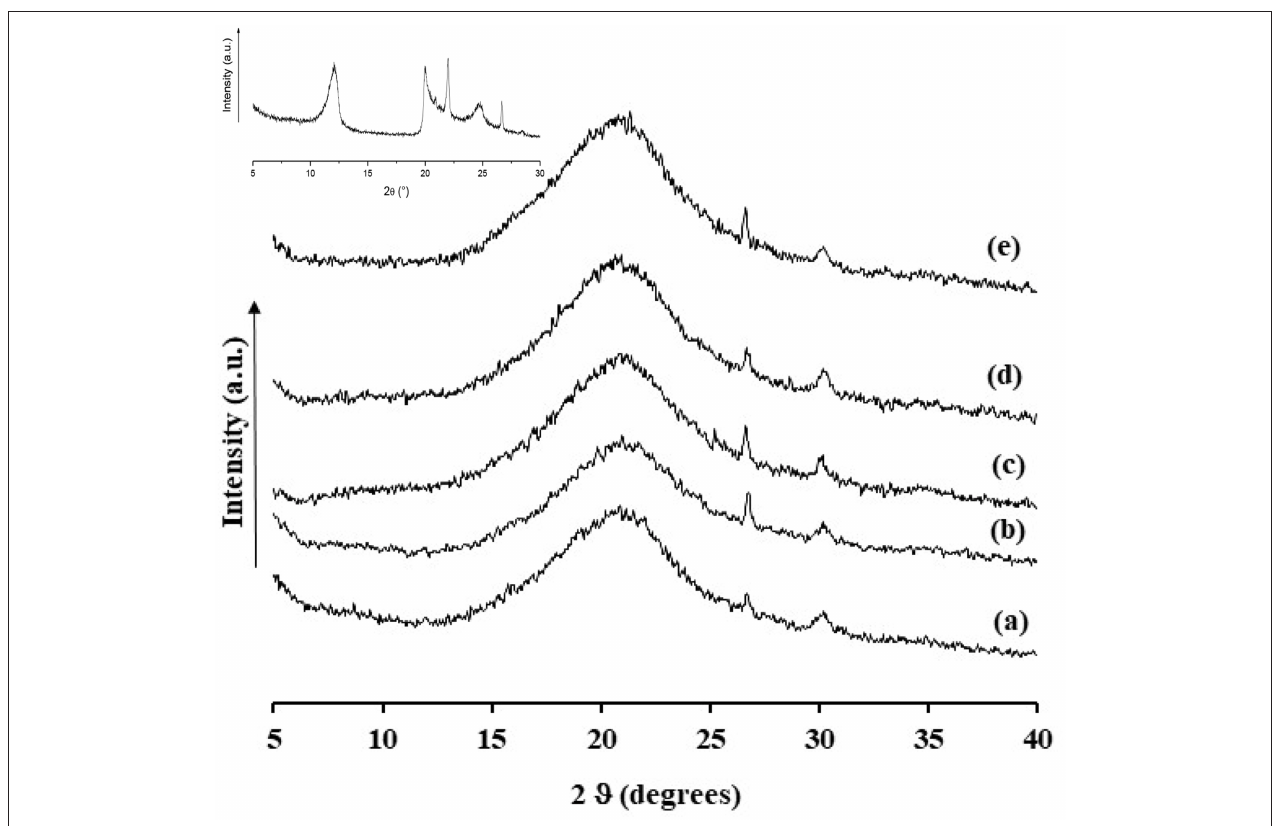
FIGURE 3 | XRD analysis evaluated on films of TPs100HNTs-carv0 (a) , TPs97.5HNTs-carv2.5 (b) , TPs95HNTs-carv5 (c) , TPs90HNTs-carv10 (d) , TPs80HNTs-carv20 (e) ; Inset: XRD of